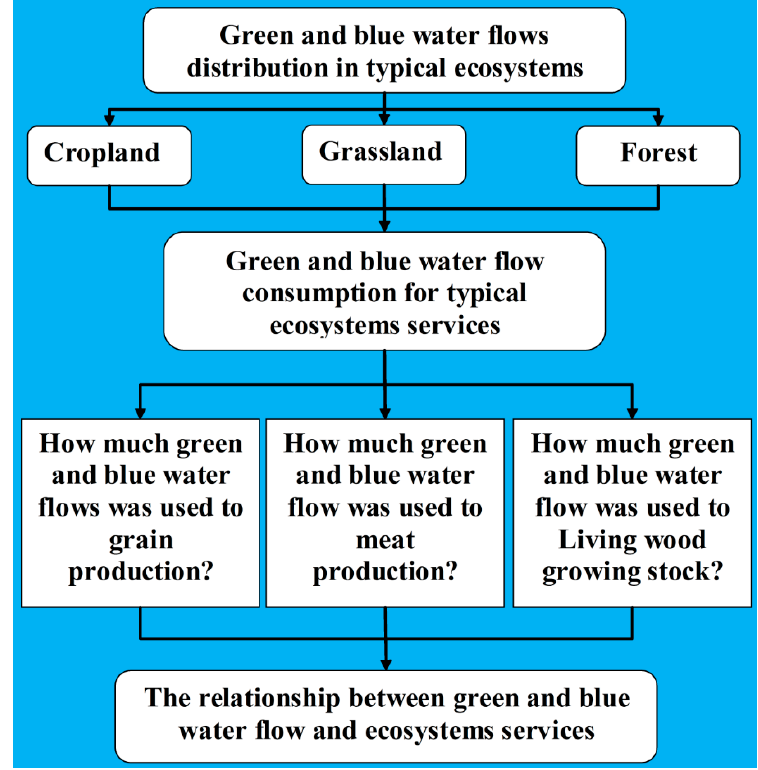
Figure 1. The research framework of this article.